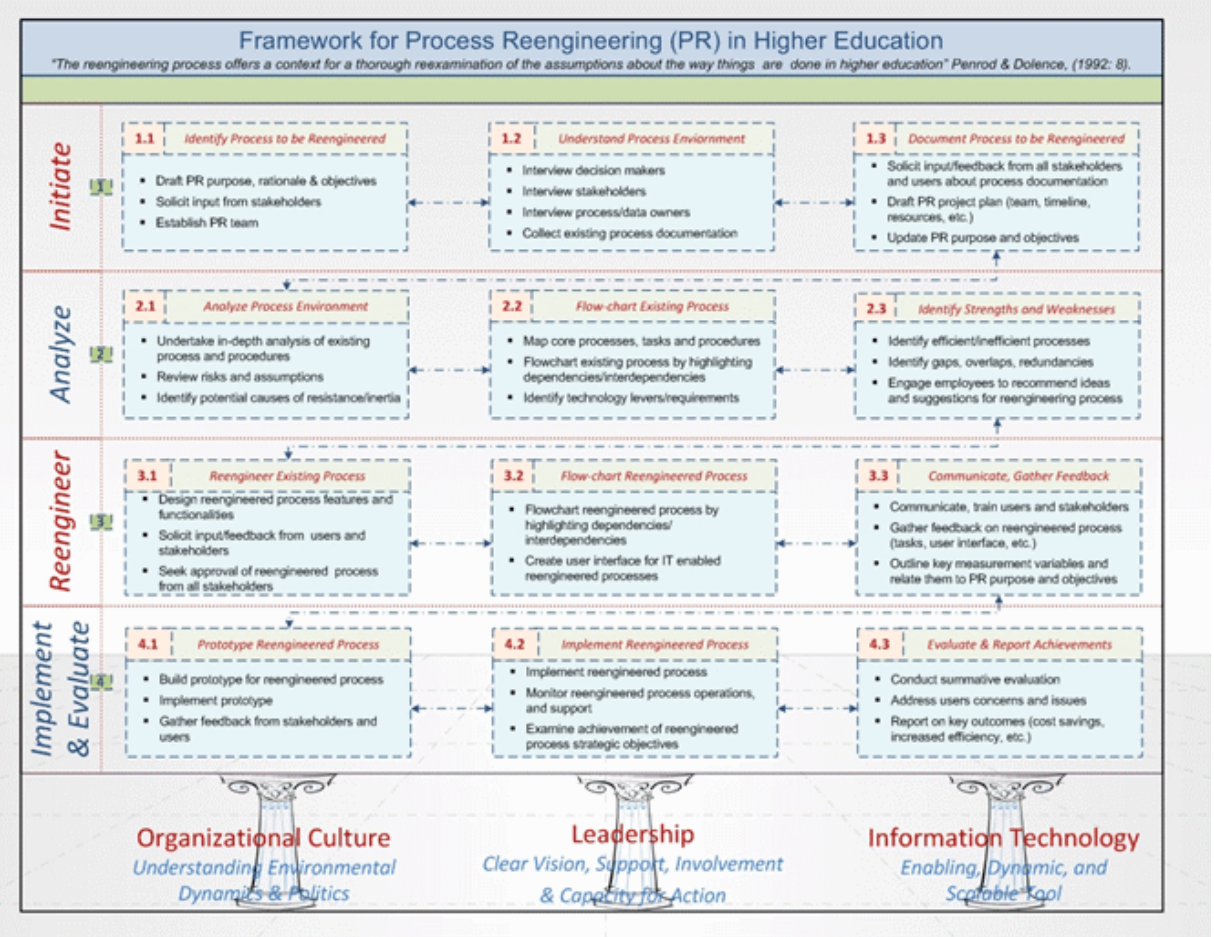
Figure 1. Proposed process reengineering